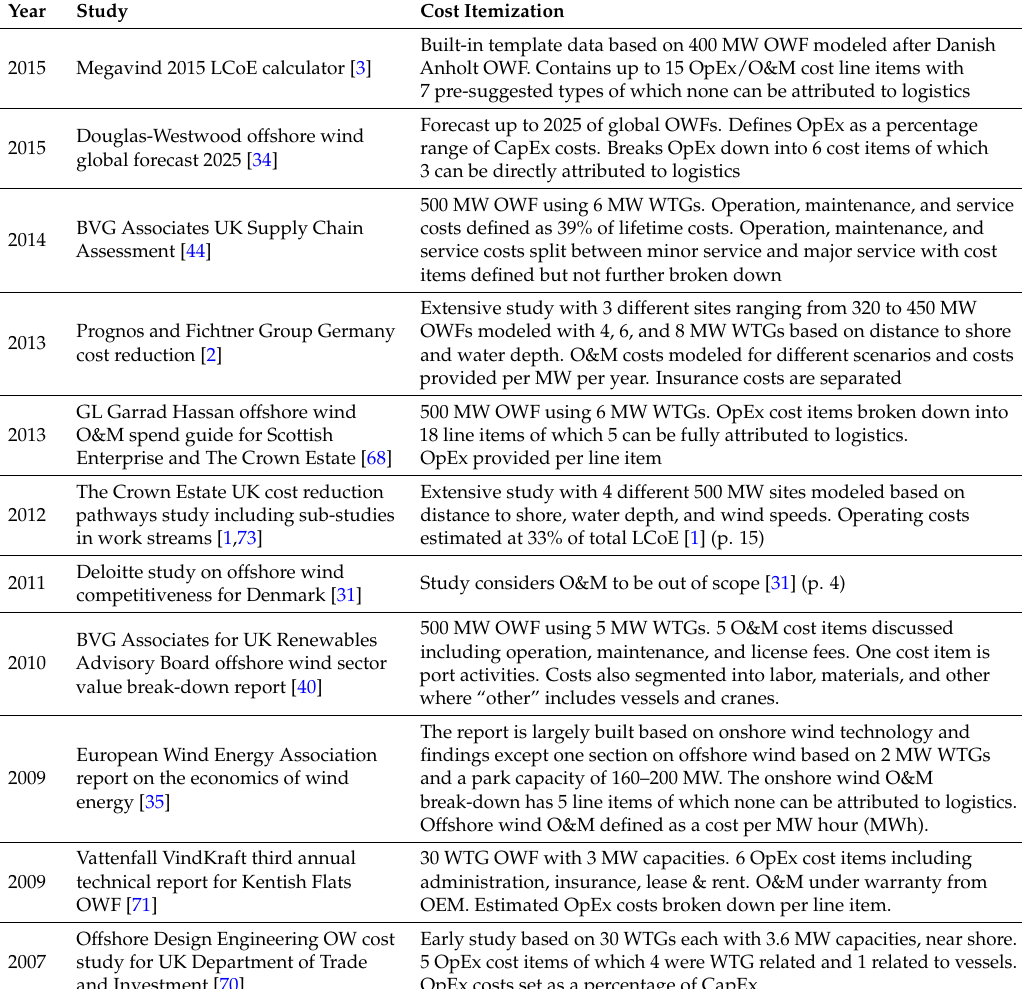
Table 1. Analysis of inclusion of O&M logistics in eleven major LCoE related